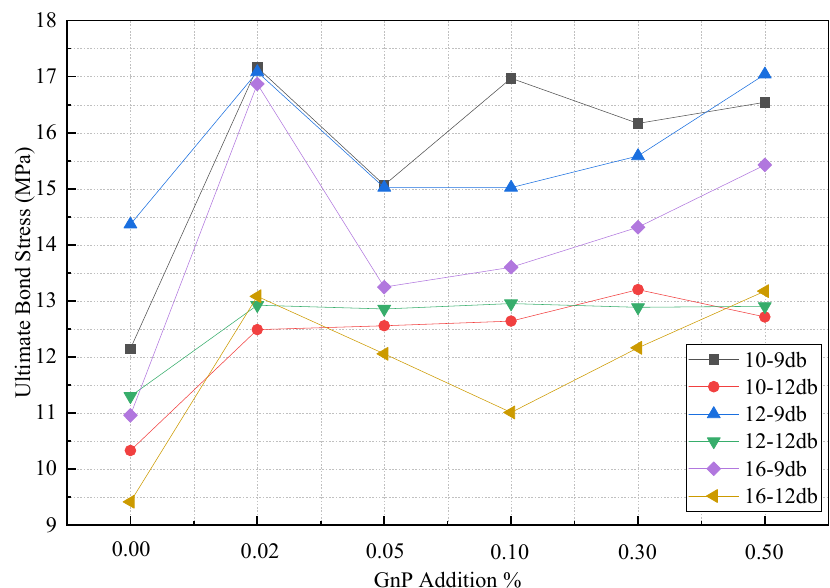
Figure 10. Effect of GnP inclusion on the ultimate bond stress.